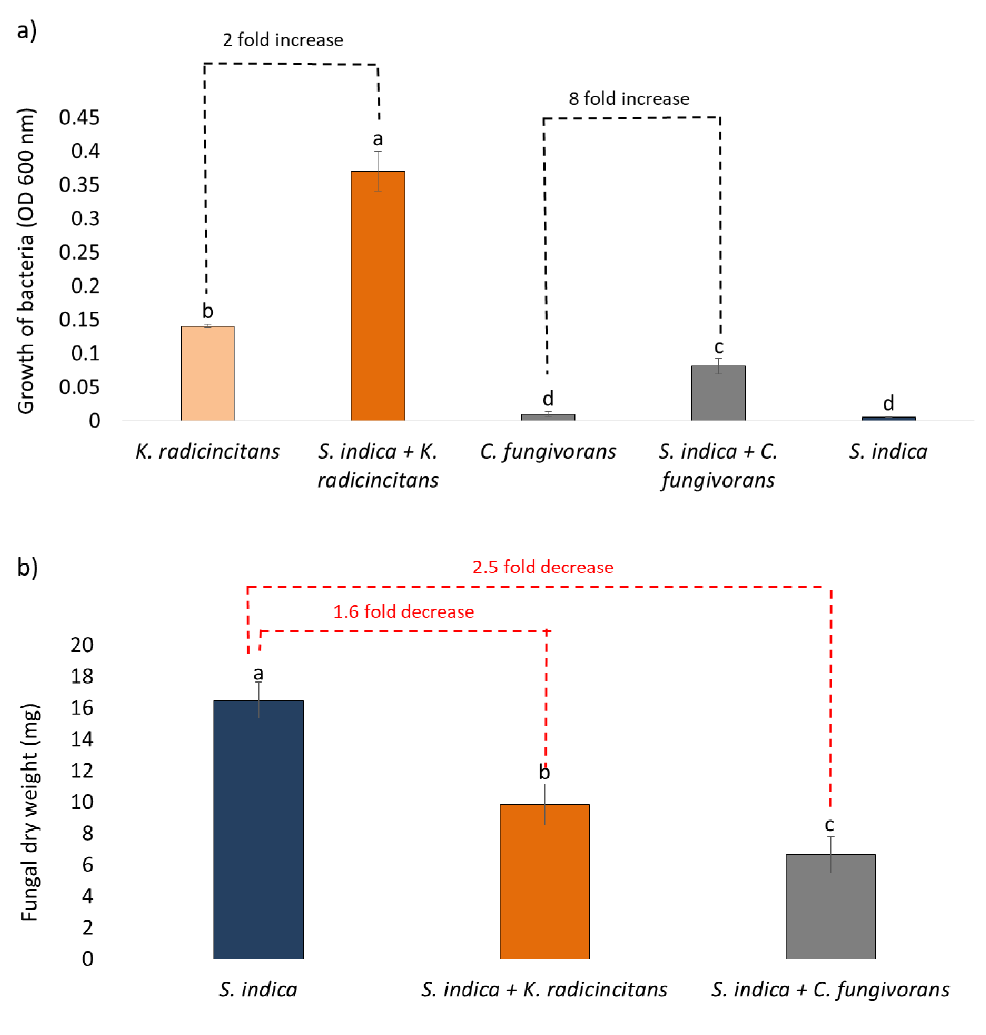
Figure 1. Results of mycophagy assays. ( a ) Growth of Collimonas fungivorans and Kosakonia radicincitans when co-cultivated with Serendipita indica as the sole source of carbon. ( b ) Fungal biomass of S. indica when co-cultivated with either C. fungivorans or K. radicincitans , or the uninoculated fungus (control). Different letters above bars represent significant differences ( p < 0.05) according to one-way ANOVA followed by a Tukey’s range test. Error bars indicate the standard deviation of means of four different replicates.